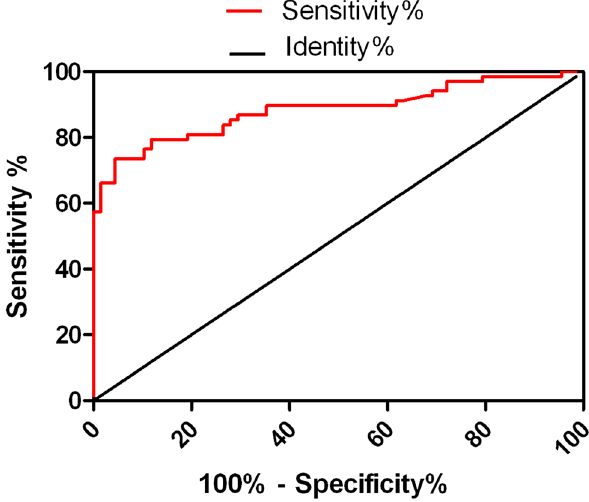
Figure 2: The area under curve of CXCL13 concentration in CSF to diagnosis the treatment failure of latent